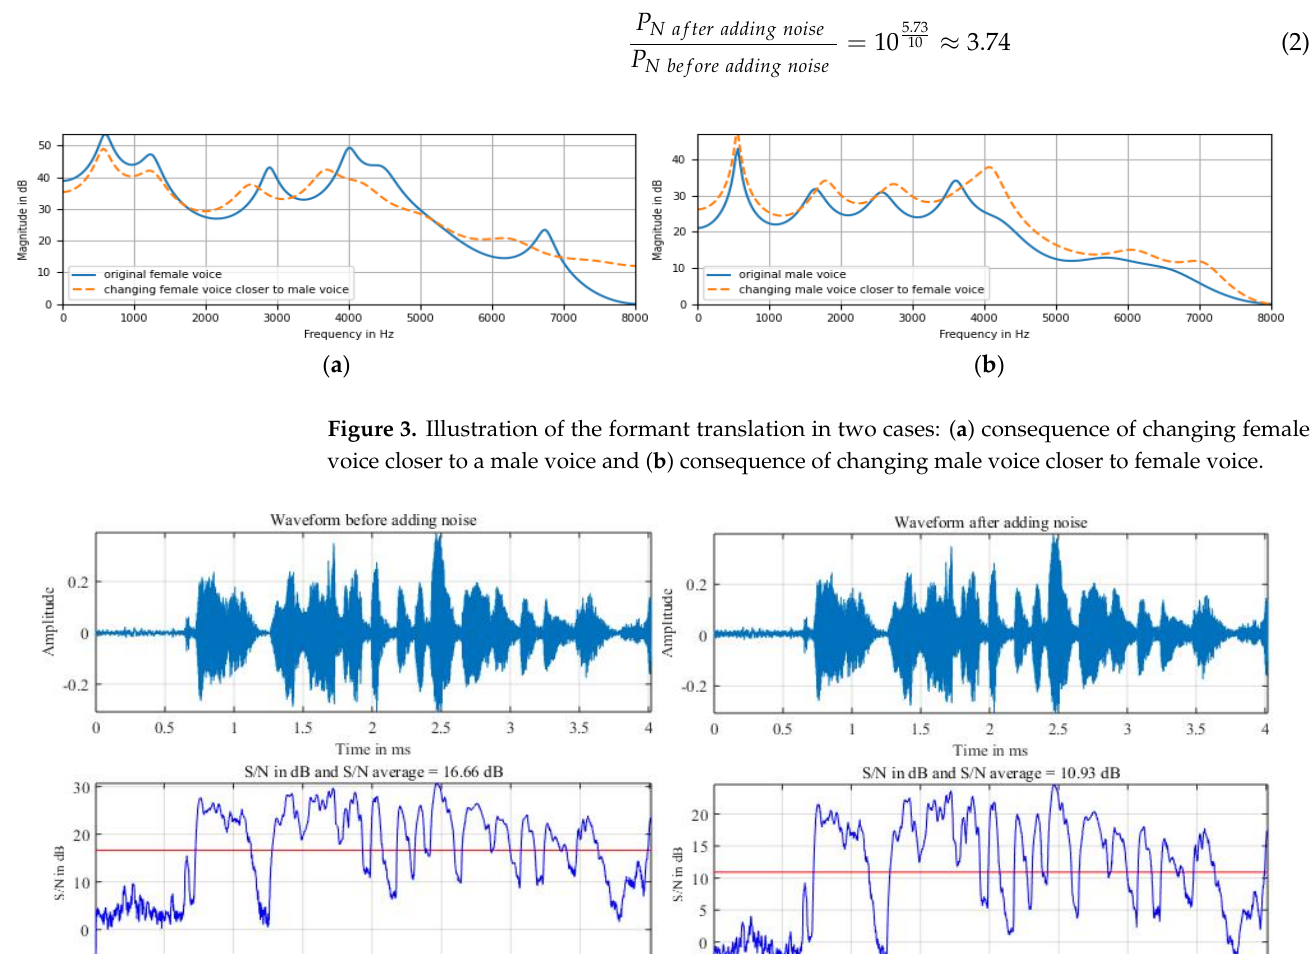
White noise was added to the speech signal using Librosa. The white ‐ noise ampli ‐ before and after noise addition, the noise power ratio before and after noise addition will be: tude was 3% of the maximum amplitude of the speech signal. Figure 4a,b illustrates the